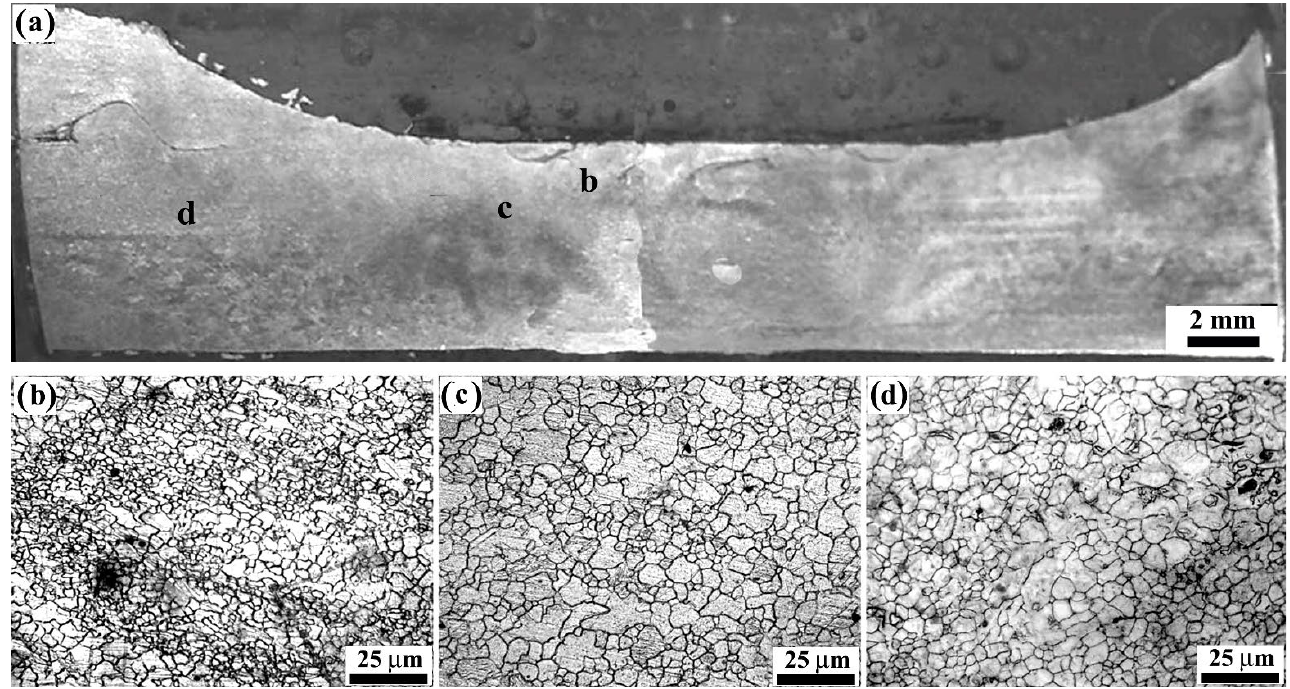
Figure 3. Macrostructure and microstructures of various regions in R-FSSW joint. ( a ) A typical macrograph of the R-FSSW joint. ( b ) SZ, ( c ) TMAZ and ( d ) BM microstructures in R-FSSW joint.